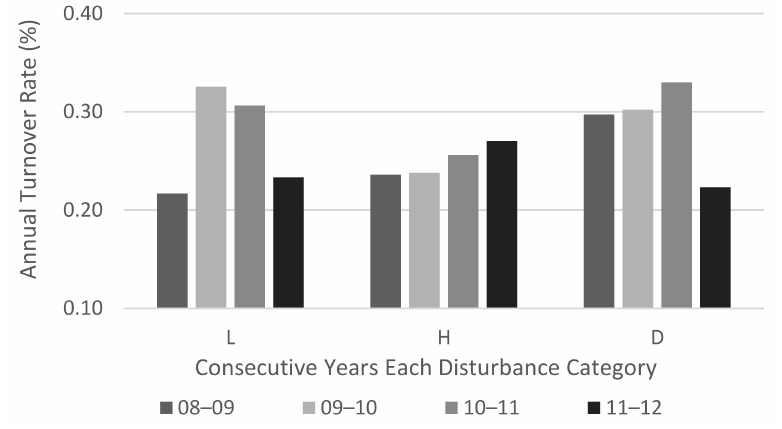
Figure 9. Annual turnover rate from 2008 to 2012 of macroinvertebrate species composition at low flood ( L ), high flood ( H ), and debris flow ( D ) disturbance